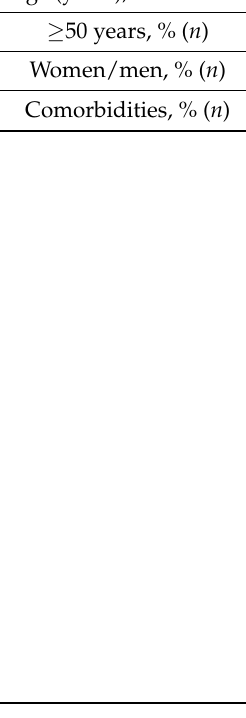
Table 1. The demographic characteristics of the studied groups of COVID-19 convalescent patients. Parameter